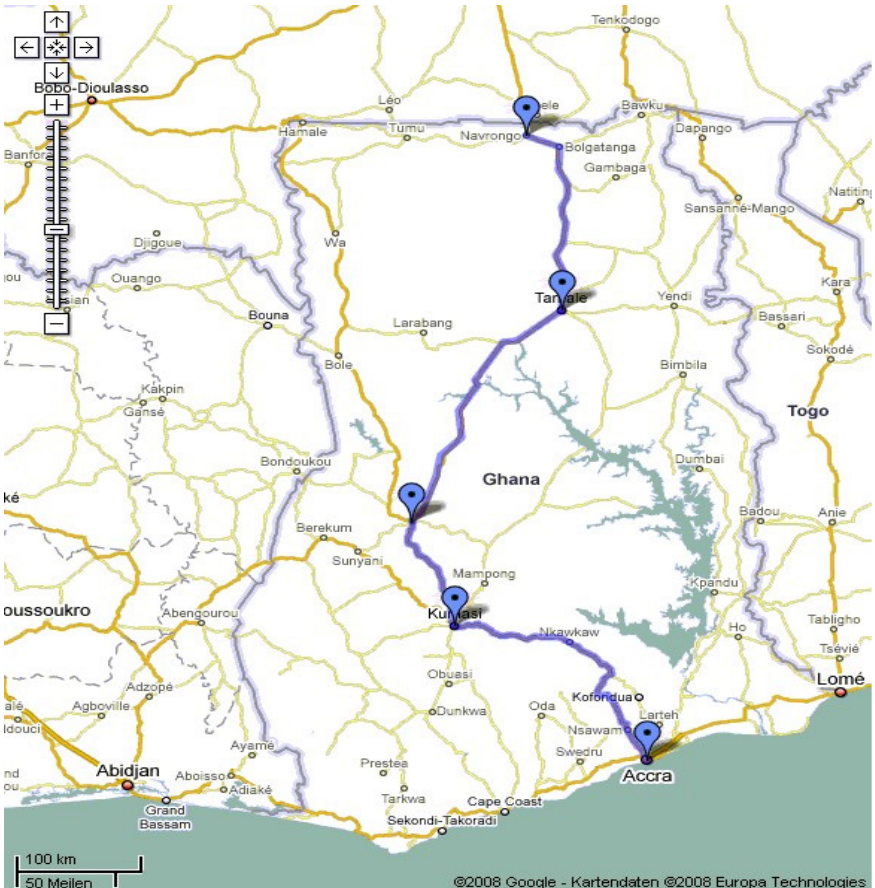
FIGURE A1: Map of Ghana showing the markets under study Source: Google